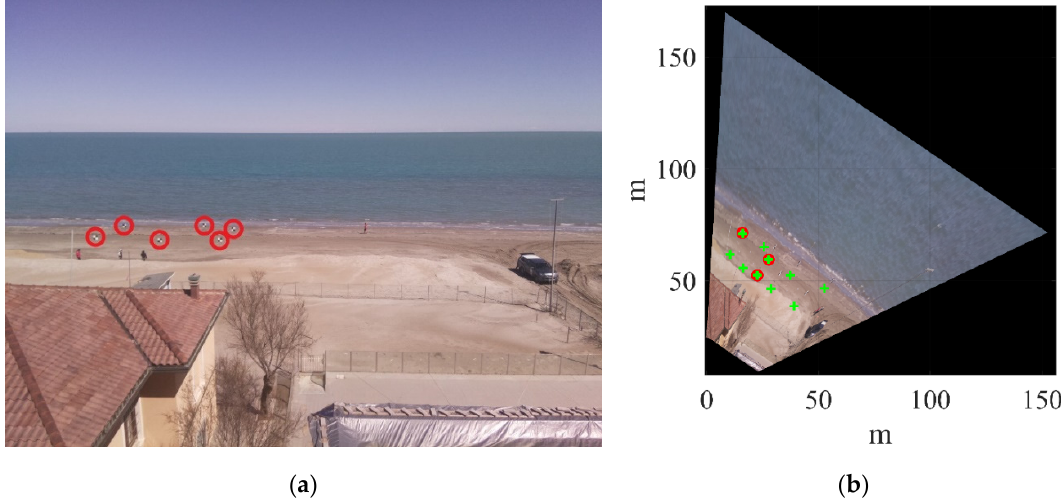
Figure A2. Rectification images: ( a ) Raw oblique image for calibration, with red circles indicating GCPs targets. ( b ) Rectified image, where green crosses and red circles are training and test data, respectively (coordinates’ origin refers to the camera position).